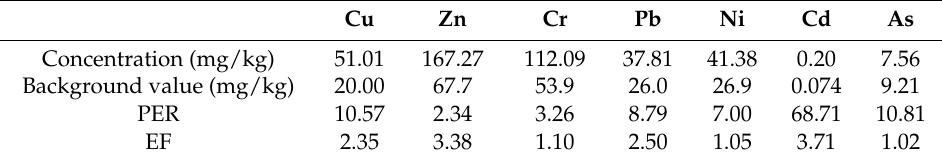
Table 3. Mean concentration, potential ecological risk index (PER) and enrichment factors (EF) of heavy metals in Haihe